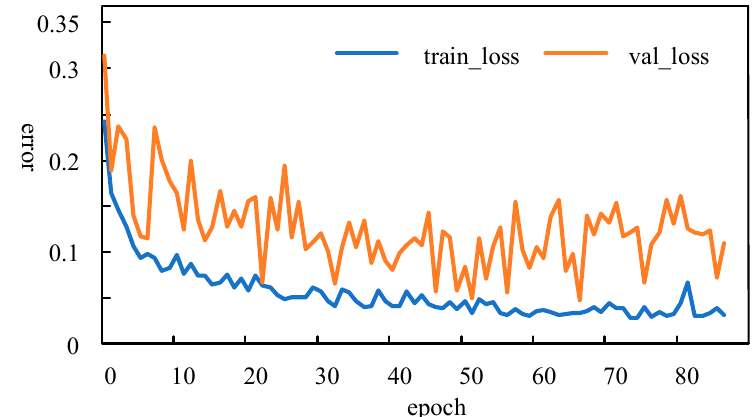
Figure 5. Graph of the trend of loss for a particular training session.